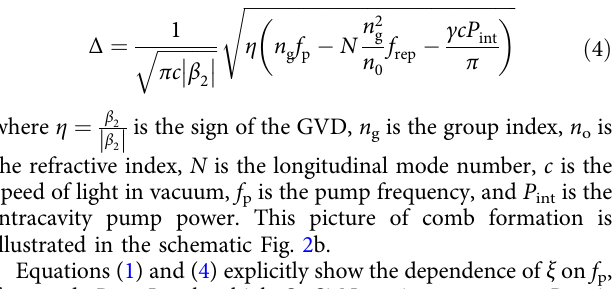
Fig. 1 Phase-locked breather comb generation and characterization. a Schematic of the current f – 2f nonlinear interferometry to measure f ceo . By comparing the higher-frequency comb segment and the second-harmonic of the lower-frequency segment, a beat note at f ceo with suf fi cient signal-to- noise-ratio (SNR) is generated on a photodetector (PD). This often requires comb spectral broadening in a highly nonlinear fi ber and/or a broad octave- level comb span. b The unique generation mechanism of frequency microcombs provides an alternative full-stabilization route that does not require external nonlinear processes. Modulation instability and four-wave mixing then generates the initial comb lines with Δ spacing, and subsequently secondary lines with f rep spacing. Often, Δ is not an integer multiple of f rep . The frequency microcomb therefore has an offset frequency ξ innately. As elaborated later, ξ resembles f ceo in directly gauging the optical frequency instability. c Example frequency microcomb spectrum showing subcombs around primary lines yet to fully merge. d Primary comb lines are formed with a spacing ( Δ ) of 1.1 nm and then generate overlapping subcombs. e Electrical spectrum measures two distinct beat notes of f rep = 17.9 GHz and ξ = 523.35 MHz, con fi rming the presence of a unique ξ ( f ) and ( g ) Free-running change in f rep and ξ at different spectral regions are measured to be the same within error bars of ≈ 2 kHz and ≈ 200 kHz, respectively. At wavelengths where the beat notes have SNR higher than 10 dB (100 kHz RBW), 10 measurements are taken to determine the mean values of the comb spacing and offset frequencies. Measurement error bar is the peak-to-peak deviation from 10